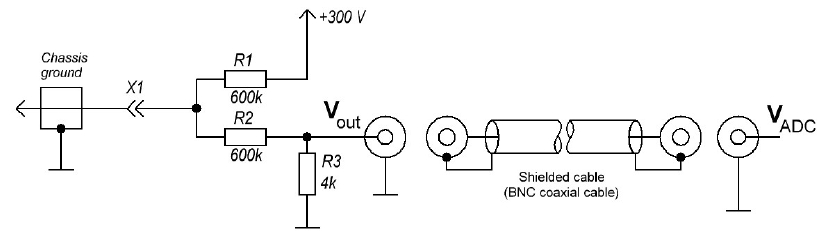
Figure 3. Electrical circuit of the simplest ion sensor.